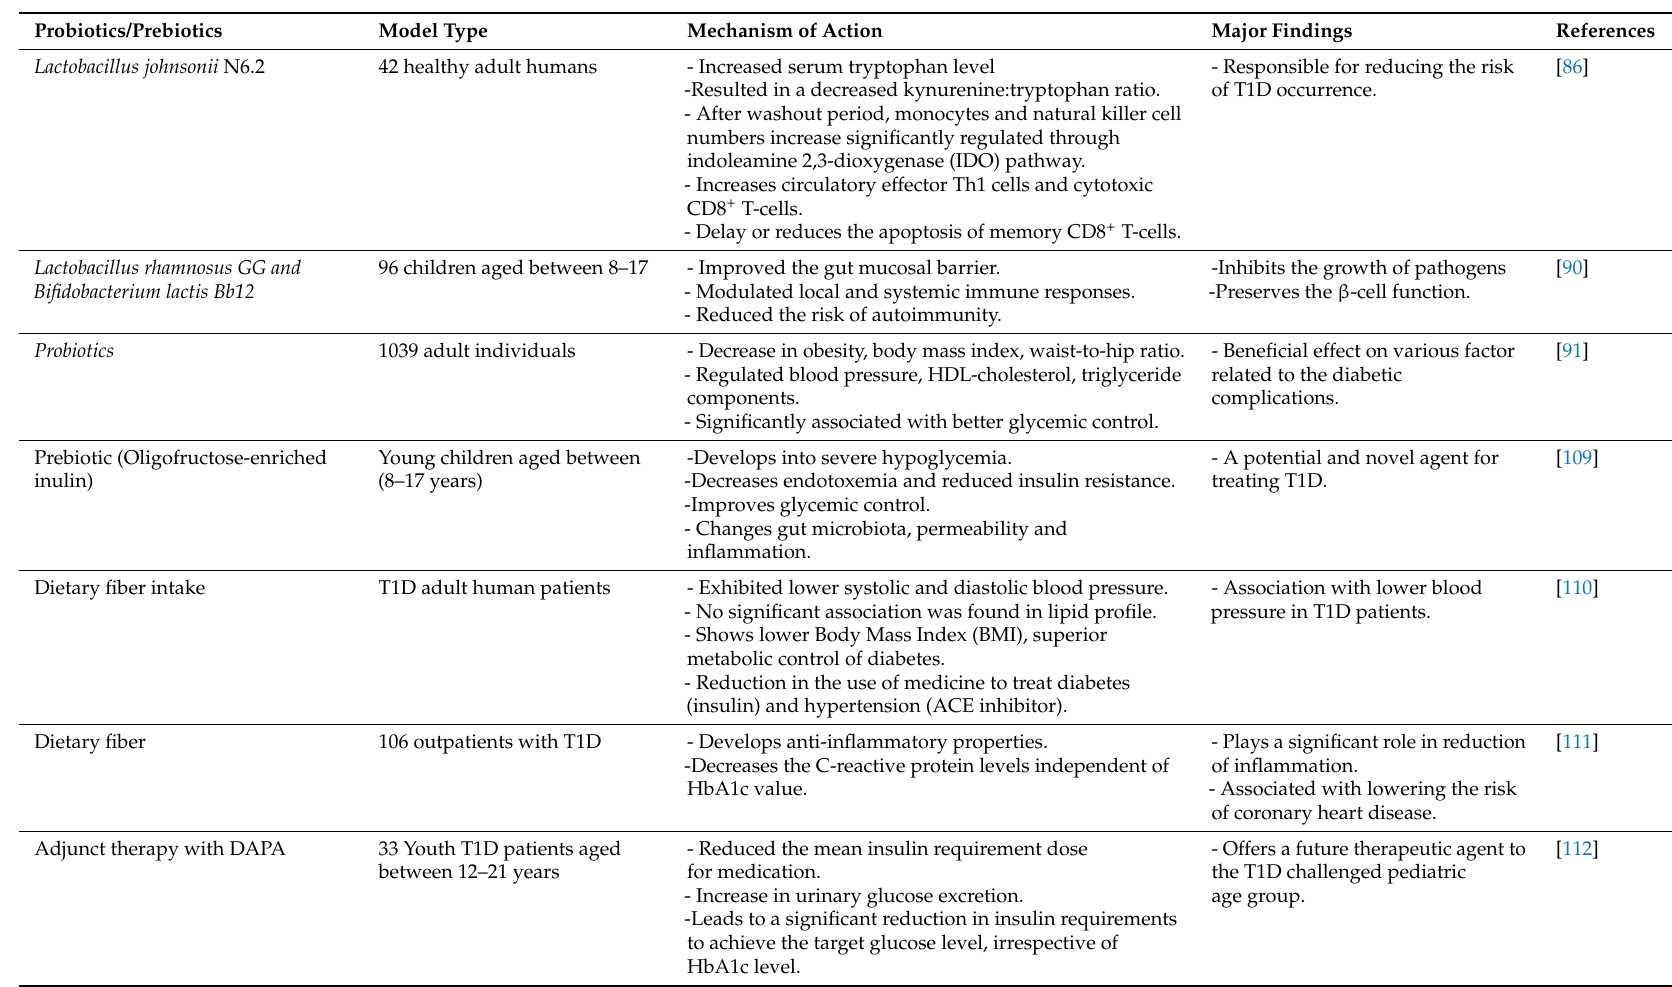
Table 2. Summary of major human studies of probiotic and prebiotic interventions and their findings related to T1D-associated features and outcomes.